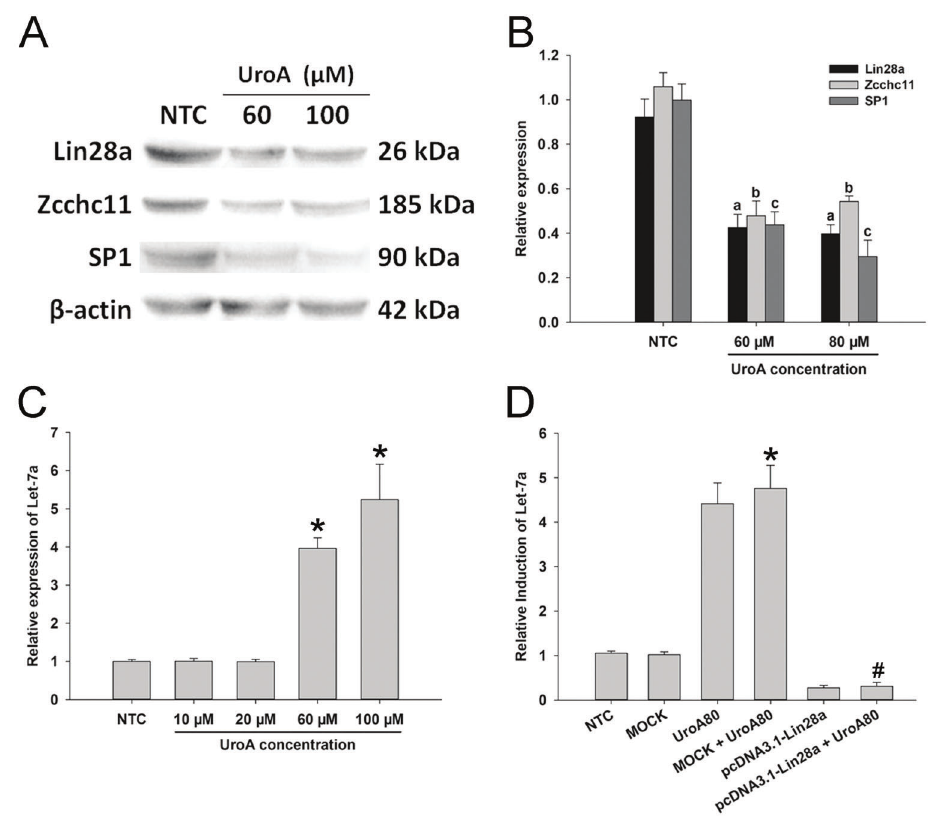
Figure 2. Urolithin A (UroA) regulated the expression of Lin28a/let-7a axis. A , The protein expressions of Sp-1, Lin28a, and Zcchc11 were assessed by western blot assay. B , Sp-1, Lin28a, and Zcchc11 protein levels were semi-quanti fi ed by western blot assay. Data are reported as means ± SD normalized to the corresponding b -actin values. a,b,c P o 0.05 vs the protein expressions of Lin28a, Zcchc11, and Sp-1 in the NTC group, respectively (n=3). C , Cells were treated with urolithin A for 48 h. The let-7a expression was quantitated by qPCR. Data are reported as means ± SD (n=3). *P o 0.05 compared to the NTC group. D , The overexpression of Lin28a abolished the effect of urolithin A on let-7a expression (n=3). *P o 0.05 compared to the MOCK control. # P o 0.05 compared to the MOCK + UroA80 group